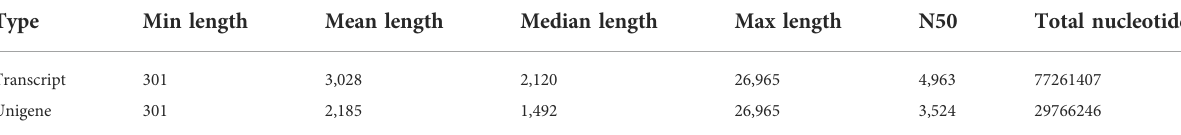
(Table 2). The average length of raw reads was 3,028 nucleotides (Table 3). After removing of adapter sequences, ambiguous reads and low quality reads, 22161005 and 19733412 high-quality clean reads were obtained with an average GC content of 56.16% and 56.74% (Table 2). Finally, all short sequences were assembled into 29766246 unigenes with an average length of 2,185 bp, a maximum length of 26,965 bp and an N50 of 3,524 bp. The length distribution of the unigenes was illustrated in Figure 5A.